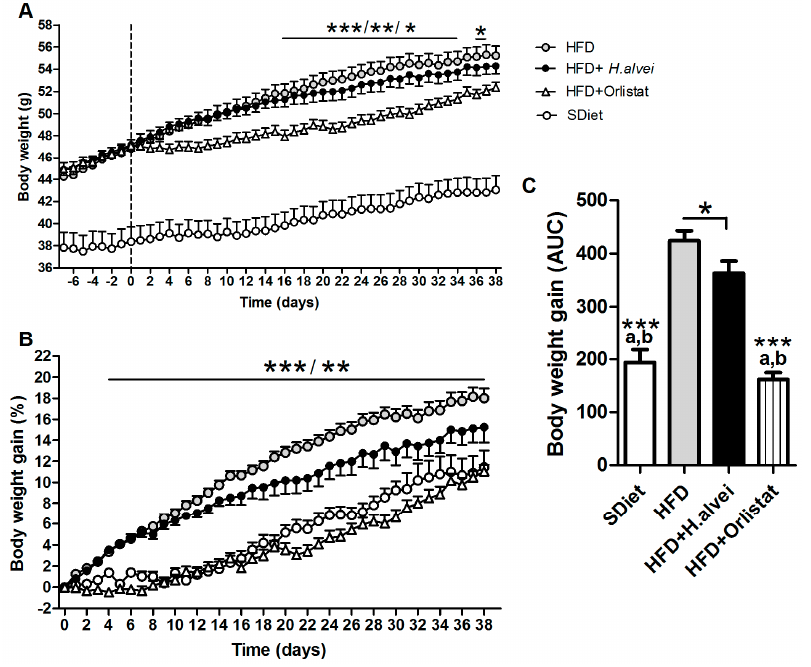
Figure 3. E ff ects of H. alvei HA4597 ™ and orlistat on body weight in high-fat-diet (HFD)-fed ob / ob mice as compared to standard diet (SDiet). ( A ) Body weight dynamics, vertical dashed line defines beginning of H.alvei or orlistat treatments ( B ) Body weight gain dynamics. ( C ) Body weight gain during treatment as an area under curve (AUC). ( A , B ) Two-way RM ANOVA, p < 0.0001, Bonferroni’s posttests, HFD vs. HFD + Orlistat, *** p < 0.001,** p < 0.01, * p < 0.05; C . ANOVA, p < 0.0001, Tukey’s posttests a vs. HFD and b vs. HFD + H. alvei , both *** p < 0.001, Student’s t -tests, * p < 0.05, (mean ± SEM; SDiet, n = 16, all other groups, n = 24).